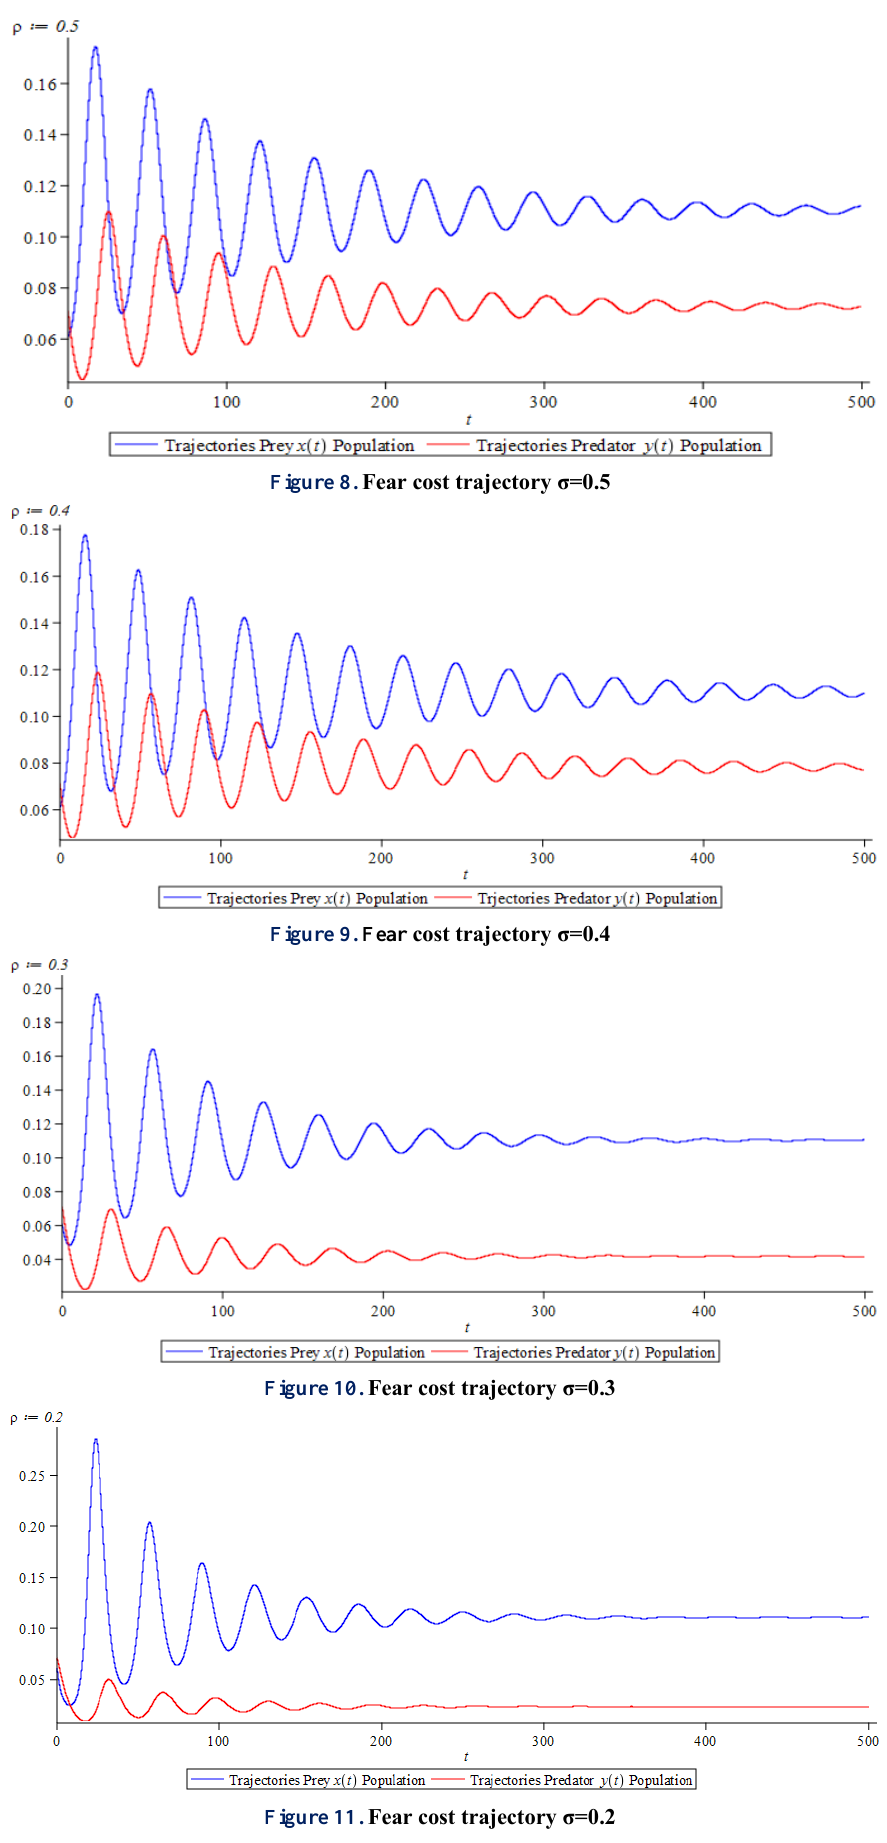
Figure 11. Fear cost trajectory